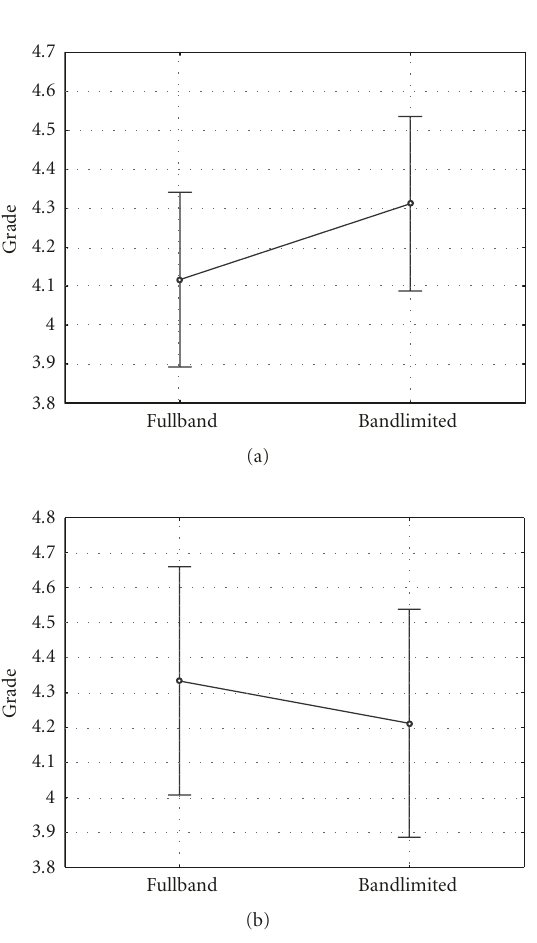
Figure 9: Means and spreads (with 95% confidence intervals) of the grades for two kinds of CCS approaches. (a) Grades of the source localization experiment. (b) Grades of the sound quality tests.